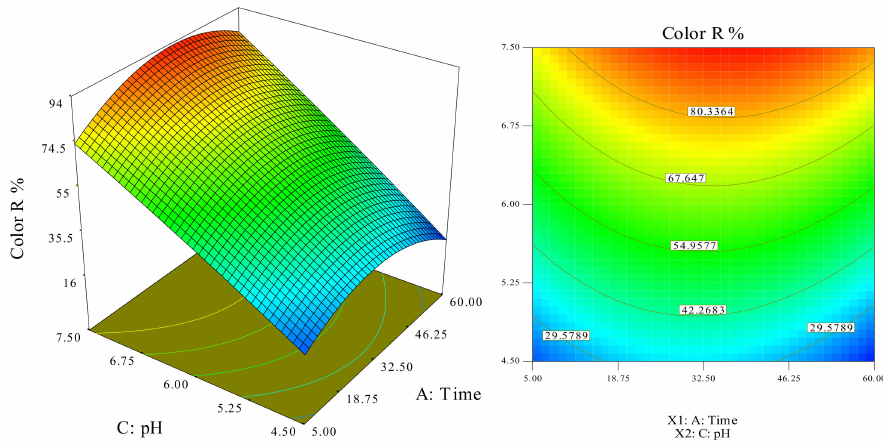
Figure 6. Role of reaction time and pH in leachate decolorization depicted in 3D response surfaces and contour